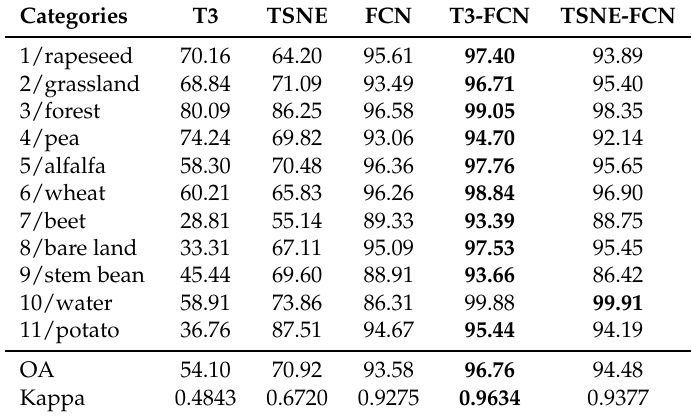
Table 2. Category accuracy (%), OA (%) and kappa coefficient of different features (classifier: SVM) on Flevoland dataset. (The category with highest accuracy is shown in